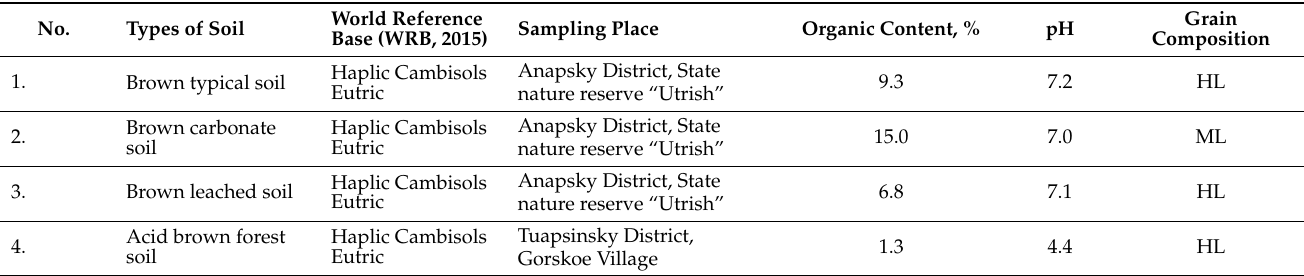
Table 1. Characteristics of the soils of the wet and dry